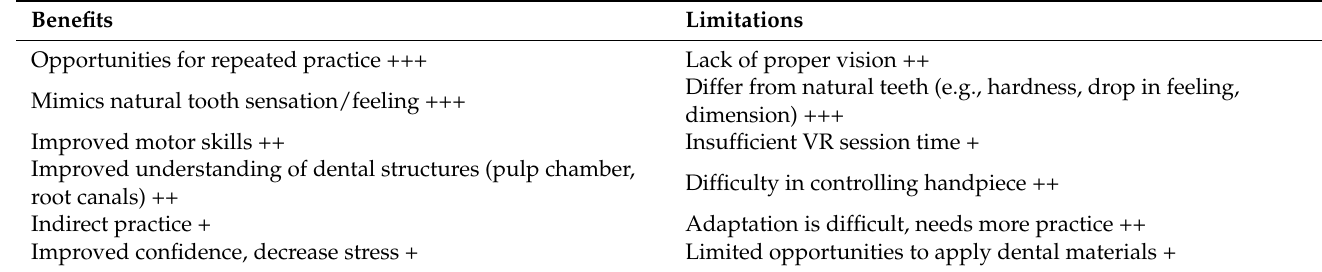
Table 3. Benefits and Limitations of Virtual Reality Simulation in Endodontics.